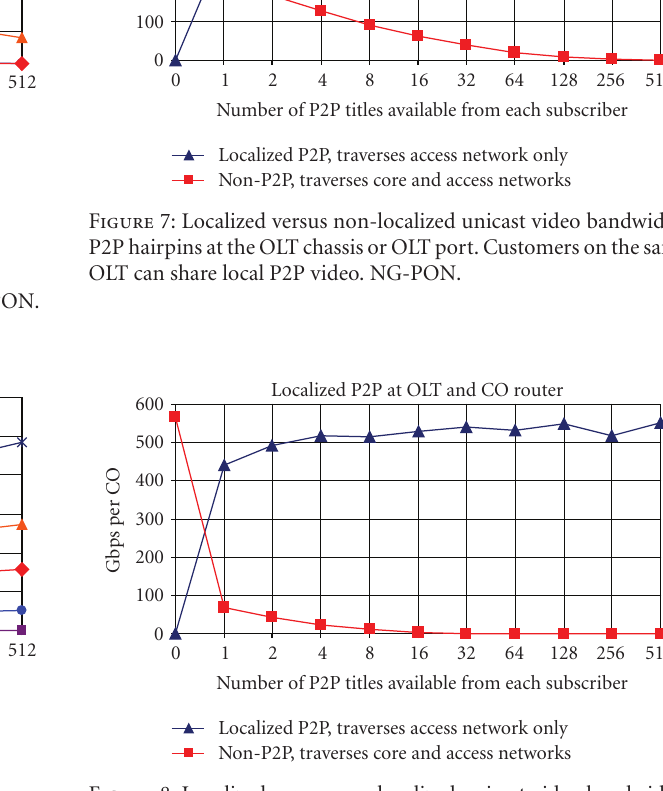
Figure 8: Localized versus non-localized unicast video bandwidth. P2P hairpins at the OLT chassis, or OLT port, or CO-router. Customers at the same CO can share local P2P video.